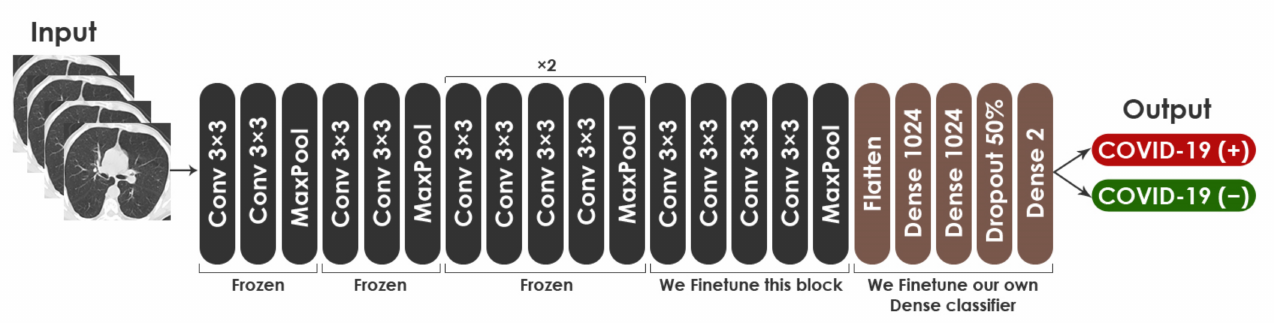
Figure 11. Architecture of modified VGG19. Conv: Convolutional